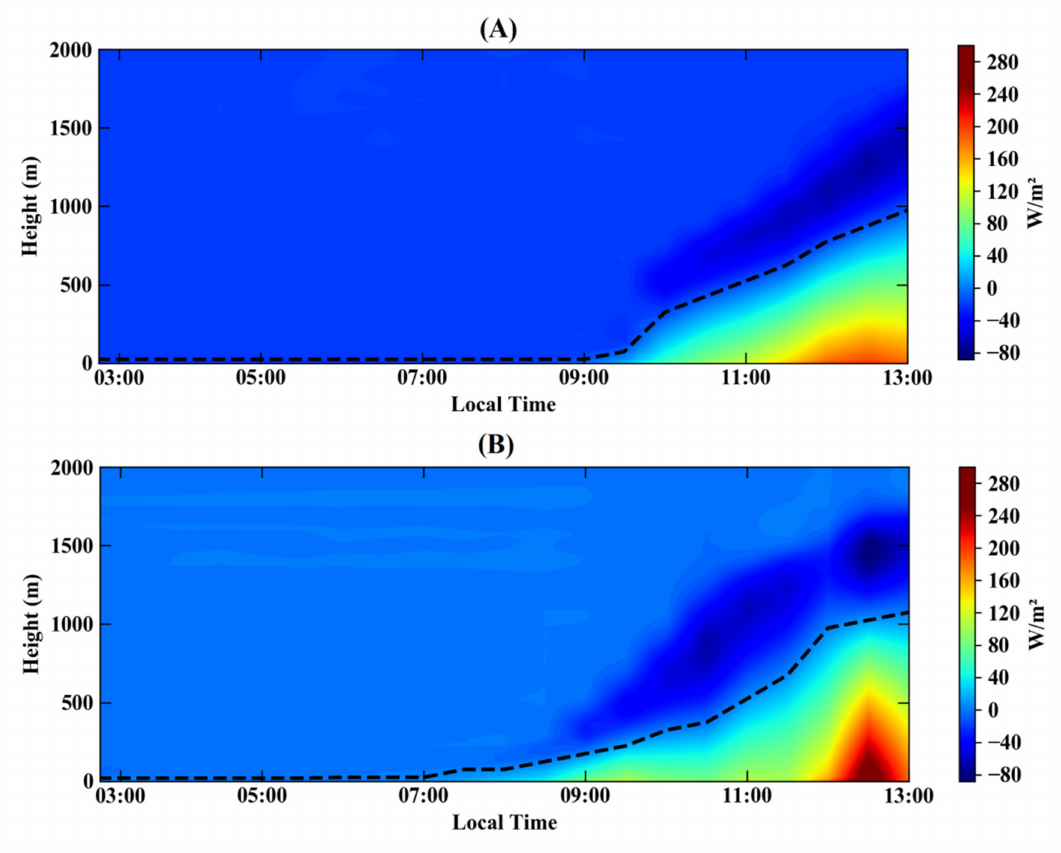
Figure 3. Time series of the vertical profiles of the horizontally averaged sensible heat flux ( w (cid:48) θ (cid:48) ) simulated by the PALM model over the GoAmazon site for ( A ) IOP 1 and ( B ) IOP 2. The dashed line represents the height where the flux is null ( w (cid:48) θ (cid:48) = 0).